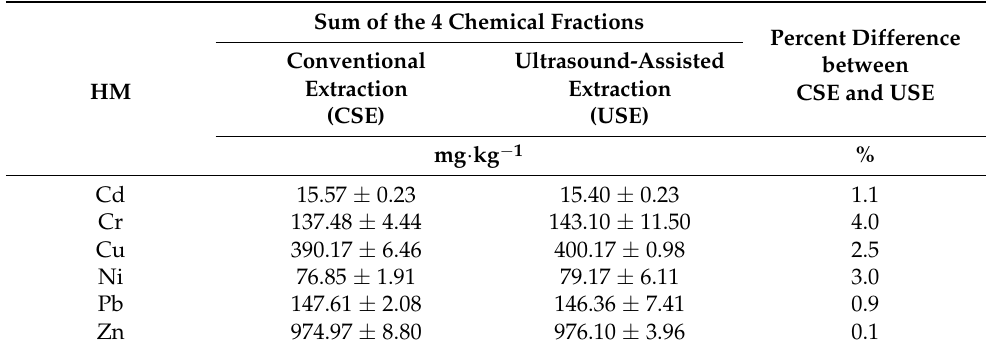
Percent Difference between CSE and